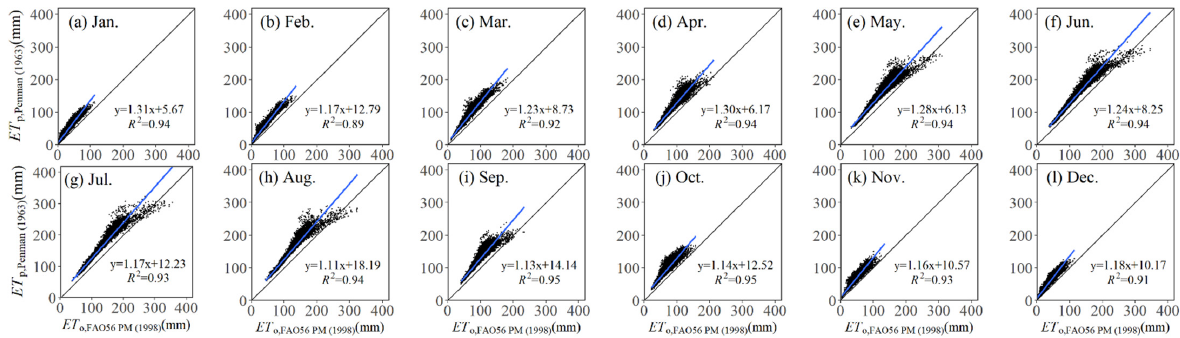
Figure 3. The variations in monthly ET o and ET p averaged from 551 sites in mainland China. To further show the value differences, the scatter plots of ET p and ET o between 1961 and 2018 in the 12 months of the year are shown in Figure 4. The monthly ET p and ET o ranged from 1 to 356 mm and from 2 to 323 mm, respectively. Most of the data-points were in the upper-left side of the 1:1 line, and some large values were in the upper-right part of the 1:1 line. These generally indicated a larger monthly ET p than ET o , especially in the cold months of November to March. The deviations of the monthly ET p from ET o were larger and increased with the increase in their values. Furthermore, the slopes of the linear function ranged between 1.11 and 1.30, indicating deviations of 11–30% from the monthly ET p to ET o. There were very high R 2 values (0.89–0.95) representing a linear correlation between ET p and ET o , which confirmed the similarity in their patterns. Although there were slight differences in the R 2 values of the cold months and warm months, this may be due to the variation in the meteorological data, which were using different weights in the two ET equations. Across the entire study area in each month, the relationship between the two was generally close.